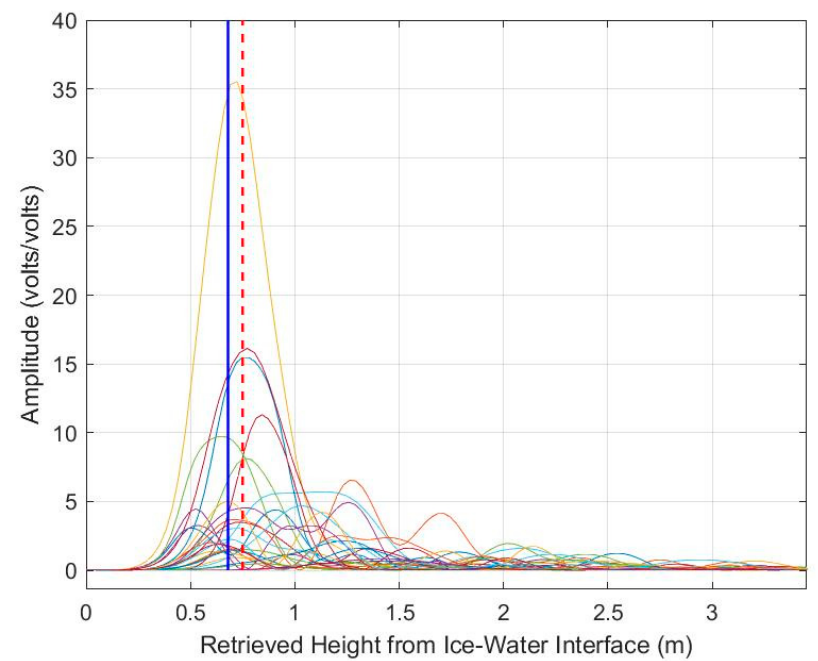
Figure 1. SNR spectrum obtained by LS-HE for a GNSS antenna installed on the top of the ice surface at Waite Lake (Site ID 6 in Table 1). Different colors represent the spectrum from different satellites. The dashed red line shows the median of the dominant peaks obtained from each satellite and is determined to be the antenna phase centre height (the distance between the antenna phase centre and the ice–water interface) (0.75 m). The solid blue line shows the estimated ice thickness of 0.68 m following application of the offset to account for the distance between the ice surface and the antenna phase centre. Table 1. General description of field sites along with corresponding geographical coordinates, deployment dates and ice thickness measurements from drilled